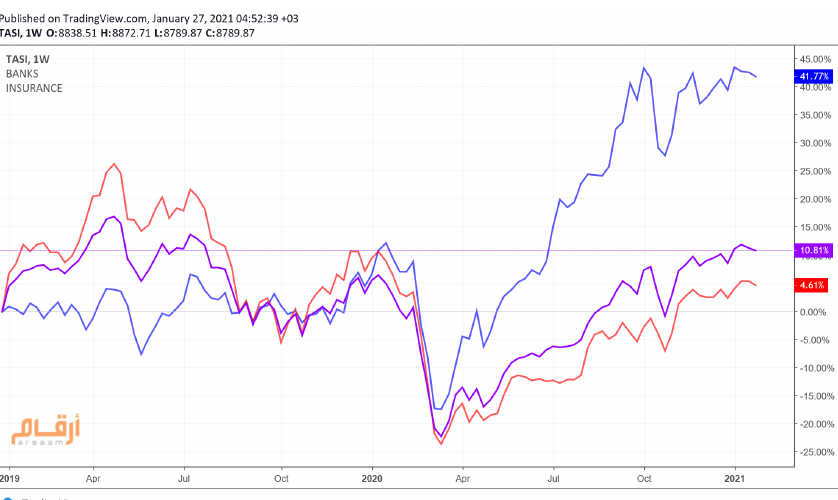
Figure 2. TASI vs. Insurance and Banking sectors since beginning 2019. In violet Tadawul index, in red the banking stock index, in blue the insurance stock index. Notice that banking (4.61%) underperformed the index (10.81%) while insurance strongly overperformed (40.71%). Source Argaam